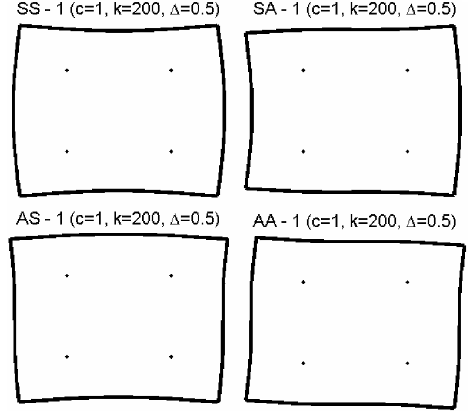
Fig. 5. Mode shapes (1 st mode, Case 2, c = 1, ∆ = 0.5).